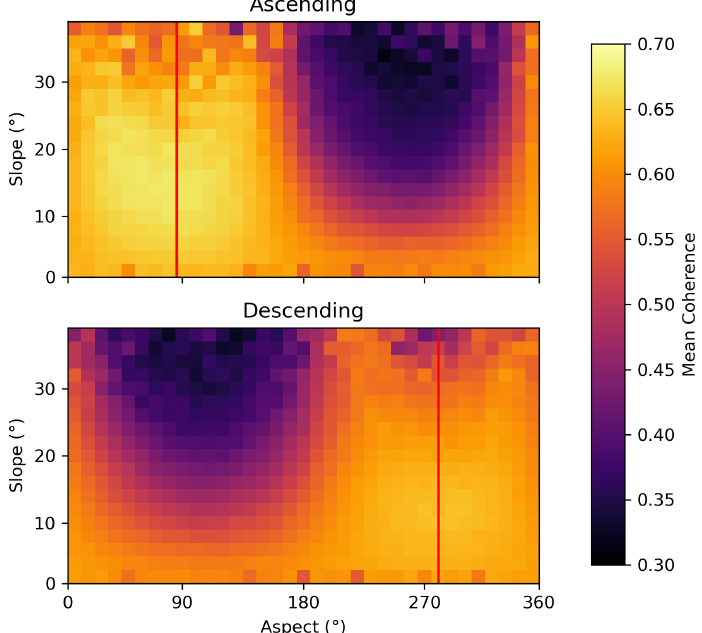
Figure 8. Heat map of average coherence for 30 m TDX pixels binned by SRTM slope steepness and aspect for an ascending pass and a descending pass. Red lines indicate the azimuth direction for each pass, which represents the aspect at which slopes face away from the